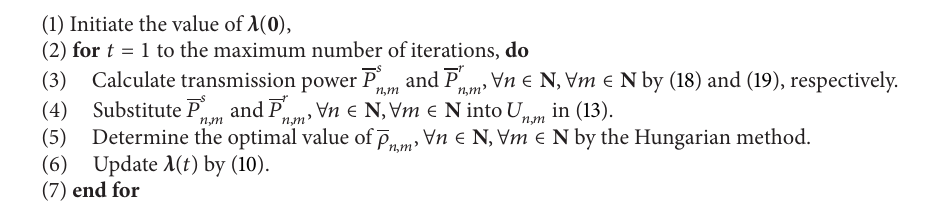
Algorithm 2: Optimal solution to (5).